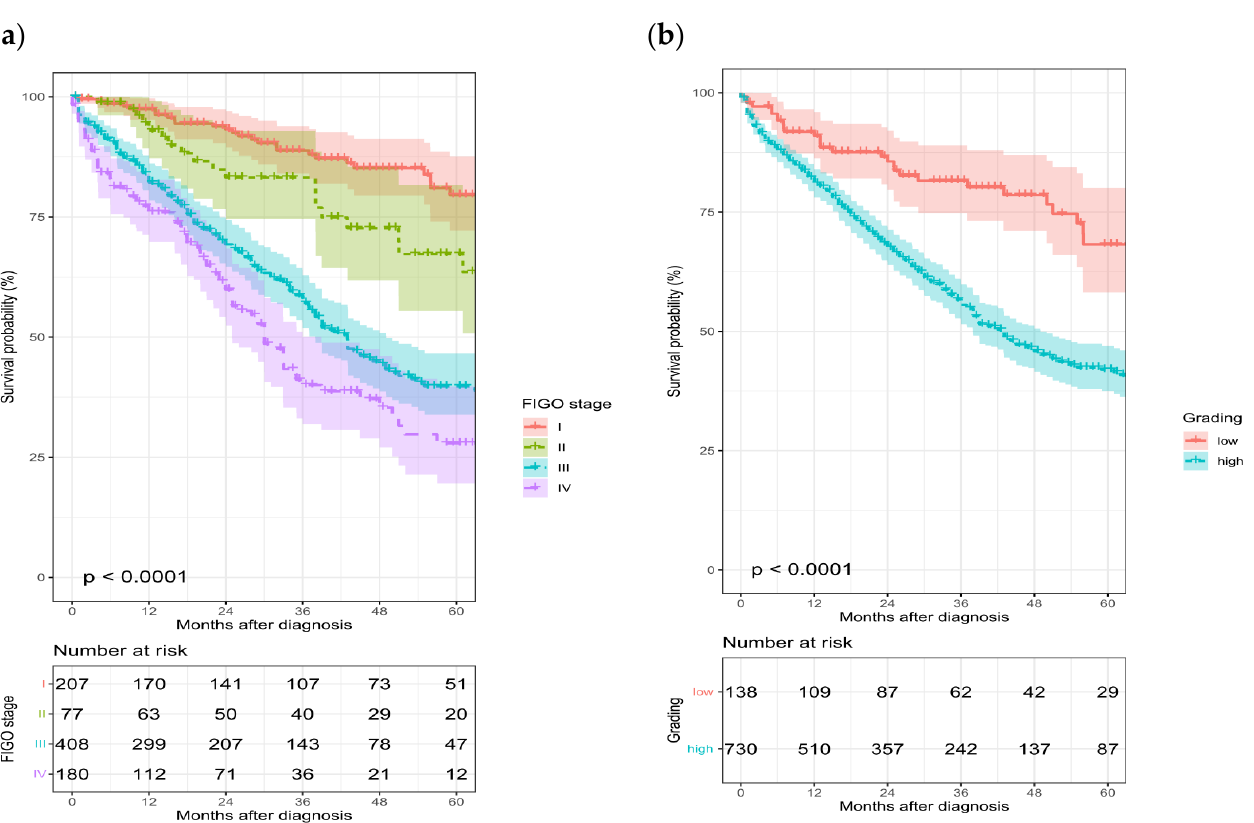
Figure 6. The 5-year survival according to FIGO stage (( a ), n = 872) or grading (( b ), n = 868), years of diagnosis 2009–2015.